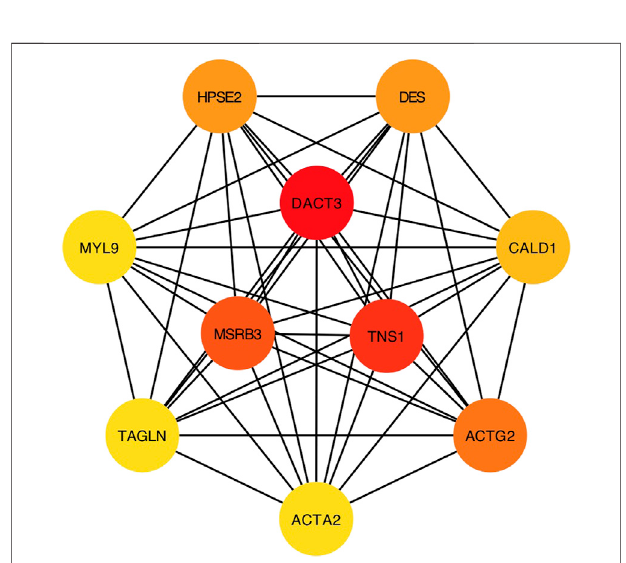
FIGURE 3 | Network visualization of interested